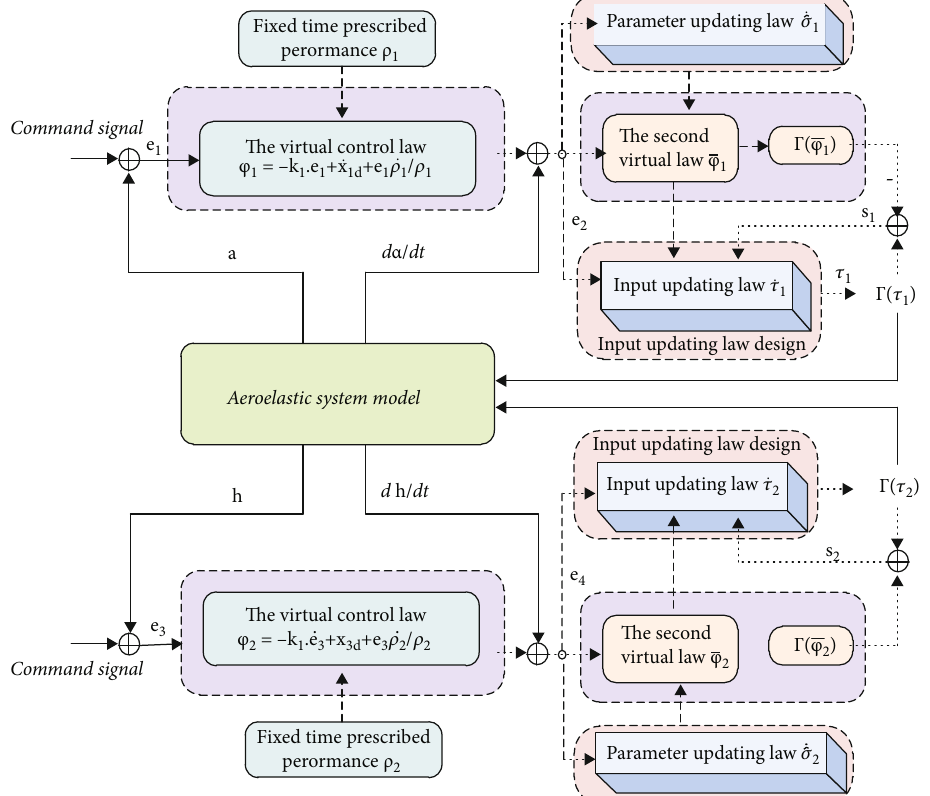
Figure 4: The closed-loop system